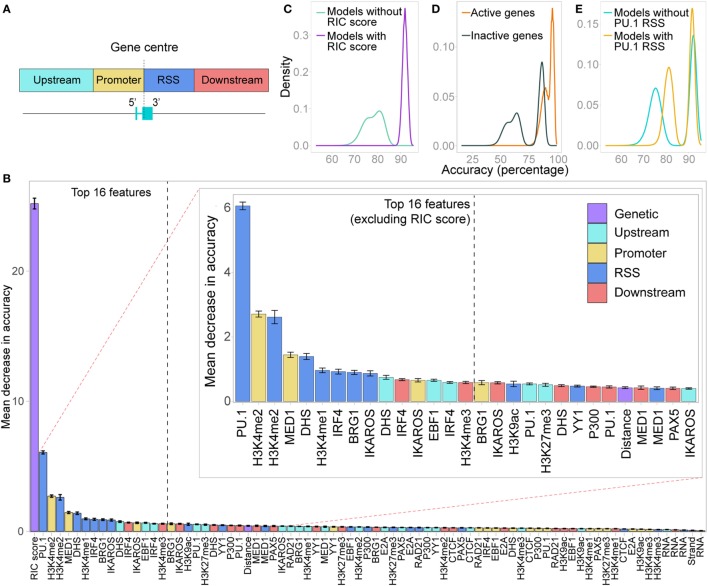
Random forest classifier (RF-C) distinguishes active from inactive genes. (A) Locations of the four windows in which chromatin features were quantified as an input to the random forest models. (B) Relative importance of all features in distinguishing active from inactive genes, shown as the average out-of-bag gini impurity (a measure of the decrease in accuracy if the feature is excluded) in a RF-C, with 10-fold cross-validation. Error bars show the SEM. Inset: zoomed-in view of the features ranked from 2 to 30 in importance. Features are coloured based on whether they are a genetic feature, or the location in which the chromatin feature was measured. (C) Overall prediction accuracy of all RF-C models trained with all combinations of the 16 most important features in the initial RF-C. Colour denotes whether the RSS Information Content (RIC) score was included in the model: all models that included the RIC score were more accurate than those that did not. (D) Accuracy in correctly predicting active genes versus inactive genes in all RF-C models. (E) Overall prediction accuracy for models that included PU.1 binding at the RSS as a feature, compared to those that did not.